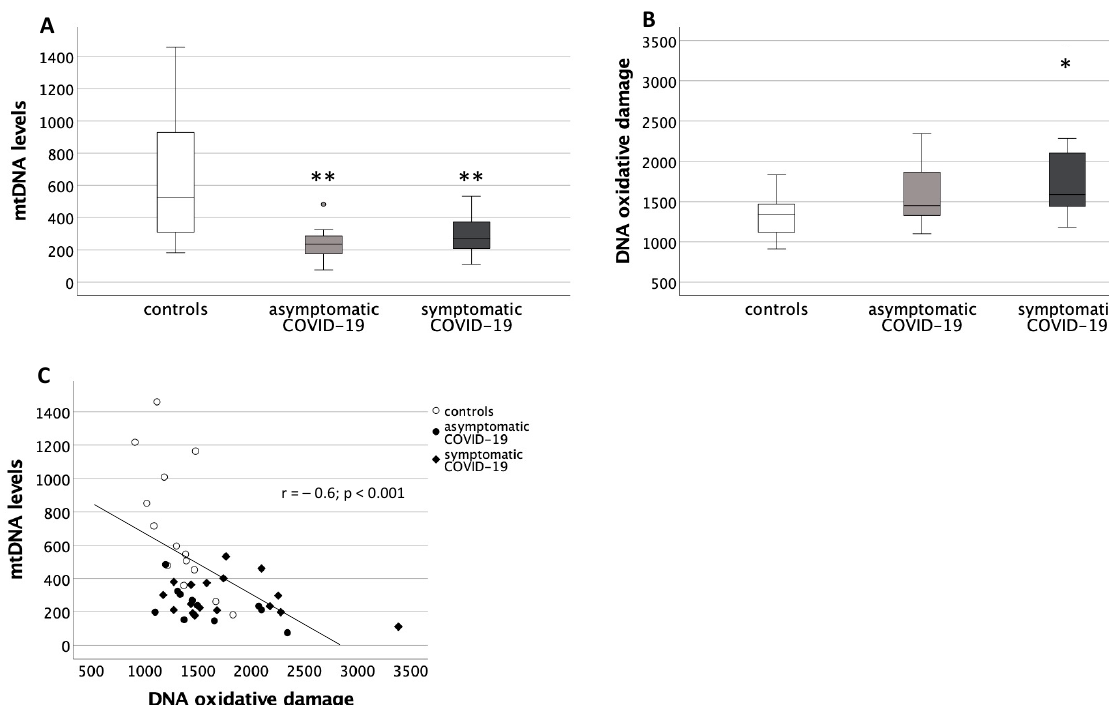
Figure 1. Mitochondrial DNA (mtDNA) and DNA oxidative damage levels in placentas from healthy control pregnancies and mothers infected with SARS-CoV-2 during the third trimester of pregnancy. ( A ) Placental mtDNA levels. Data are shown as box plots, indicating the median and the 25th and 75th percentiles. Data were significantly different among the three groups (Kruskal-Wallis test, p < 0.01). ** p < 0.01 vs. controls (Mann-Whitney U test), round circles are values that differ of more than 2 standard deviations from the median value. ( B ) Placental DNA oxidative damage levels. Data are shown as box plots, indicating the median and the 25th and 75th percentiles. Data were significantly different among the three groups (Kruskal-Wallis test, p < 0.05). * p < 0.05 vs. controls (Mann-Whitney U test). ( C ) Correlation between placental DNA oxidative damage and mtDNA levels. White circles: controls; black circles: asymptomatic COVID-19; black diamonds: symptomatic COVID-19.